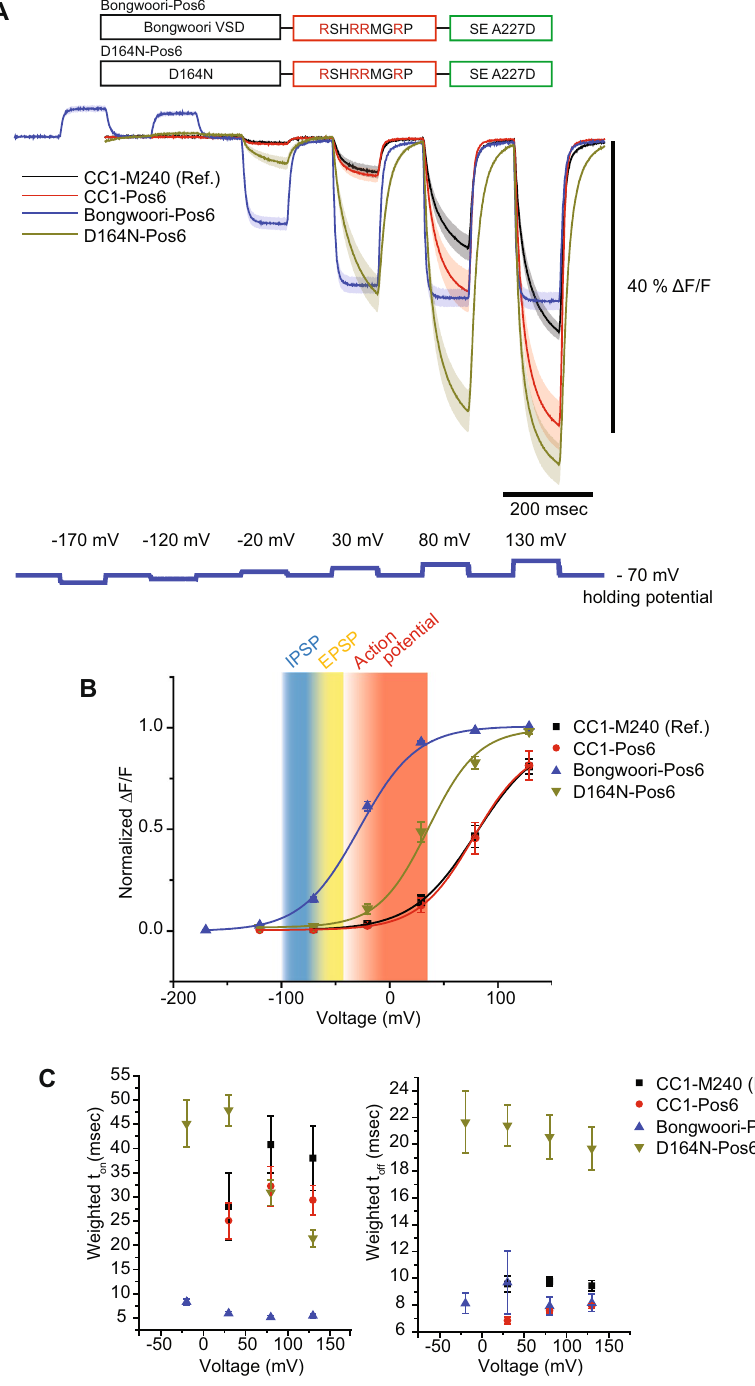
Figure 3. Adjusting the voltage sensitivity to a physiologically relevant voltage range. ( A ) Schematic showing the different VSD domains fused to the Pos6 linker and their responsive optical signals to stepped voltage pulses in HEK 293 cells. The traces from CC1-M240 and CC1-Pos6 are also shown for comparison. ( B ) The Boltzmann fit of the normalized data in ( A ) The background coding depicts the different types of neuronal activity with inhibitory post-synaptic potentials (IPSPs) shaded blue, excitatory post-synaptic potentials (EPSPs) shaded yellow, and action potentials shaded red. ( C ) The weighted time constants showing speed of the optical response as a function of voltage. For Bongwoori-Pos6 traces in ( A ), 12 trials were averaged. The shaded area and error bars denote standard error of the mean. The number of cells averaged for each construct; CC1-M240: 4, CC1- Pos6: 6, Bongwoori-Pos6: 4 and D164N-Pos6: